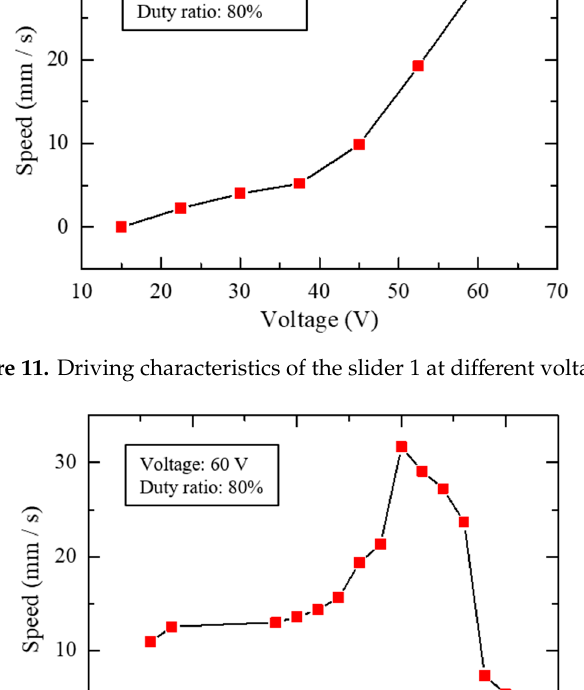
Figure 10. Experiment setup for the dual-slider driving characteristics.